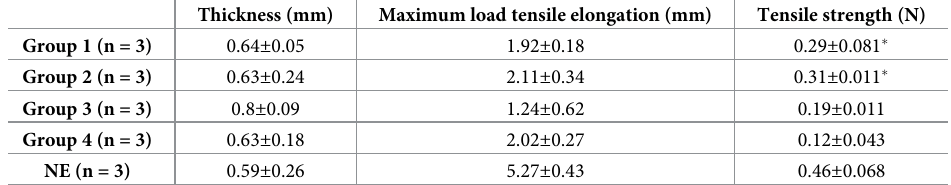
Table 2. Results of the tensile test in the bio-3D printed structures and the native esophagus of rats. Thickness